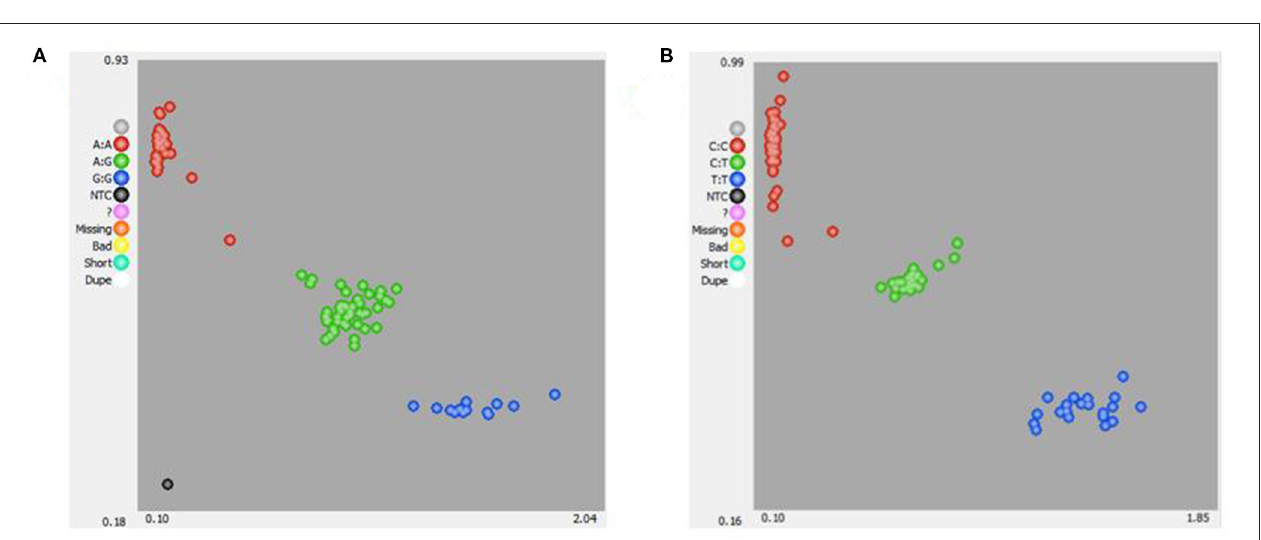
GG ( TRAPPC9 ) and CC, CT, and TT ( BAIAP2 ) ( Figure 3